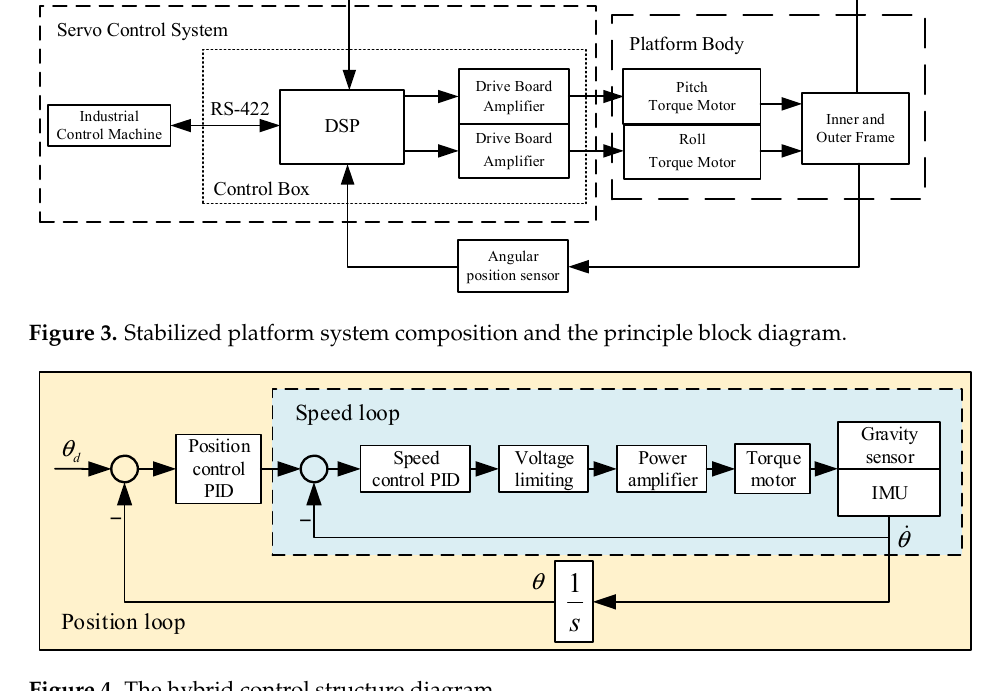
Figure 4. The hybrid control structure diagram.